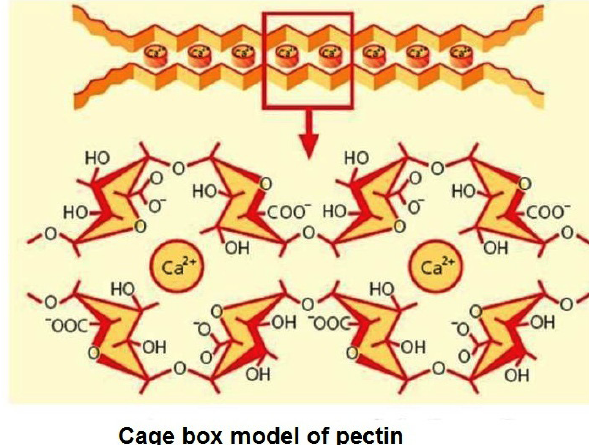
Figure 7. Egg crate model of calcium crosslinked